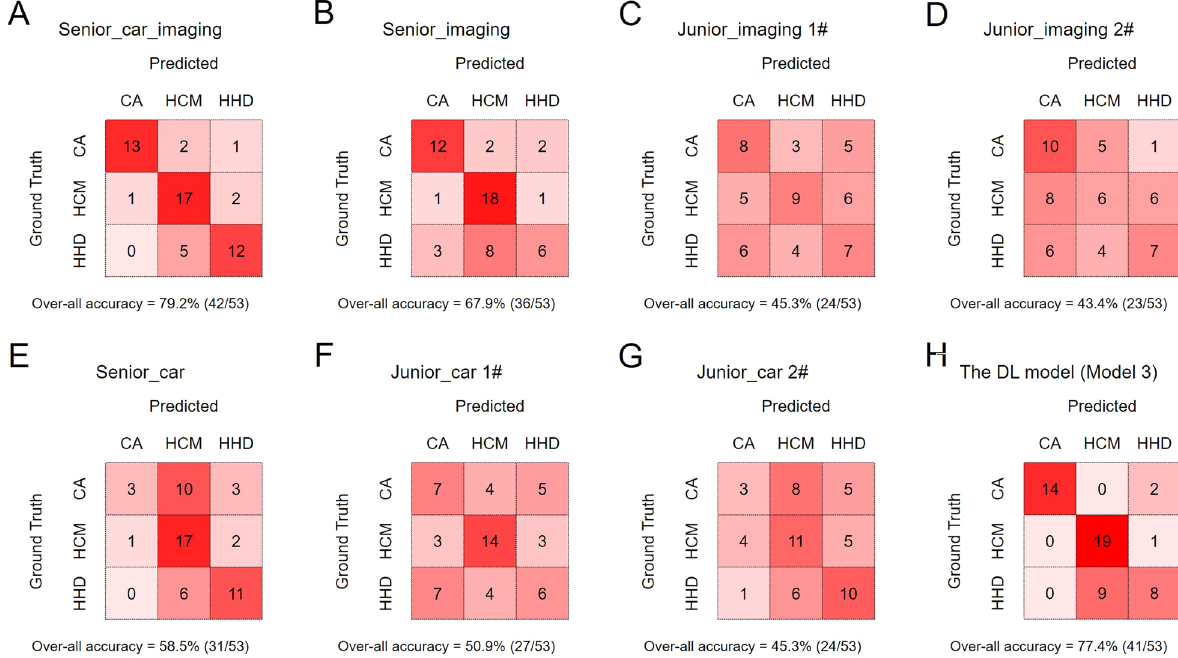
Fig. 5 Comparision of the confusion matrix between the senior cardiovascular imaging cardiologist ( A ), senior radiologist ( B ), junior radiologist 1 ( C ), junior radiologist 2 ( D ), senior general cardiologist ( E ), junior cardiologist 1 ( F ), junior cardiologist 2 ( G ) and the Model 3 ( H ) in the external test